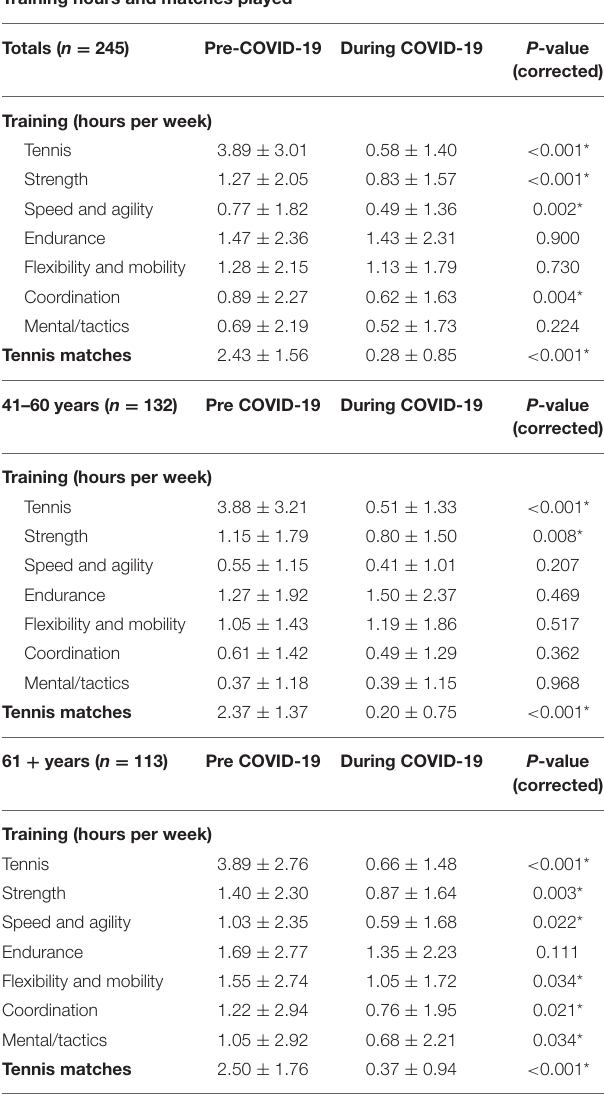
TABLE 3 | The percentage of responses regarding the training and tennis match play of participants during the COVID-19 pandemic.